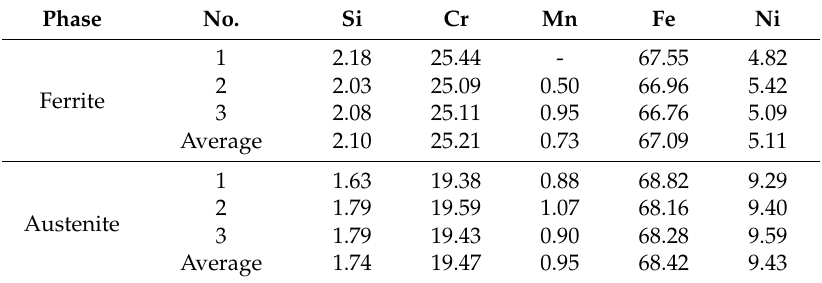
Table 2. The EDS results of the ferritic and austenitic phases in the base metal (mass %). Phase No. Phase